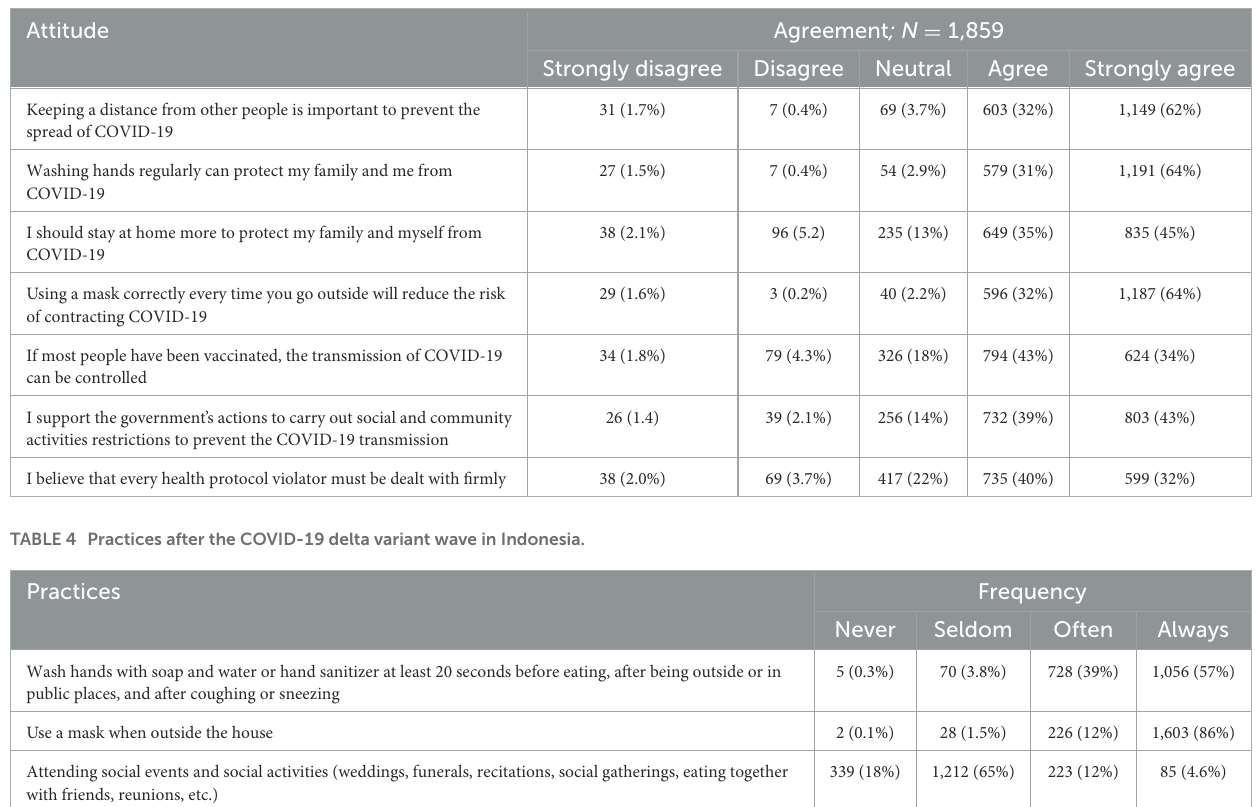
TABLE 3 Attitude after the COVID-19 delta variant wave in Indonesia.